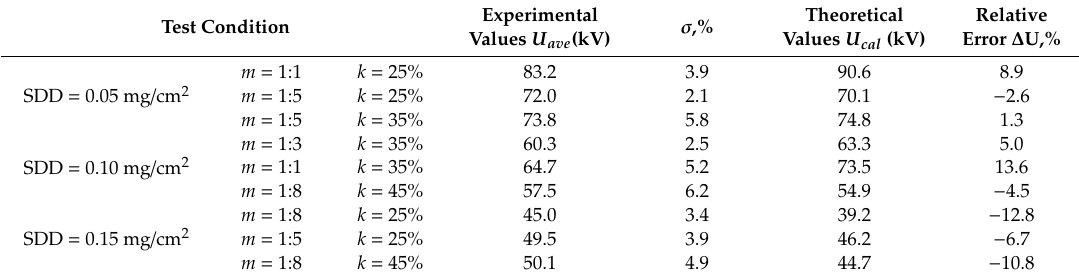
Table 2. Results of validation test. SDD: salt deposit